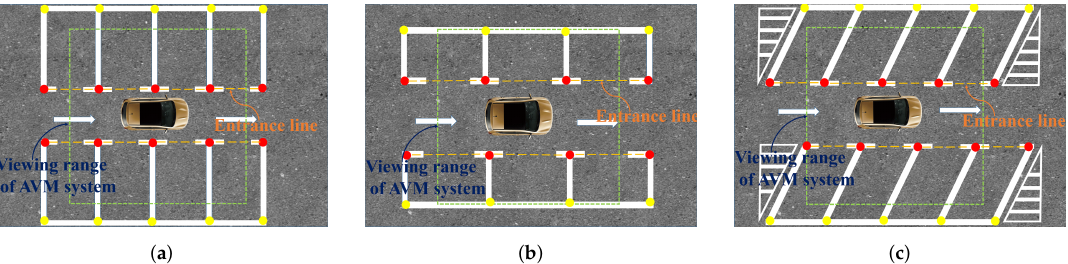
Figure 1. Three typical kinds of parking slots. ( a ) perpendicular parking slots; ( b ) parallel parking slots; ( c ) slanted parking slots. A parking slot consists of four vertices, of which the paired marking points of the entrance line are marked with red dots, and the other two invisible vertices are marked with yellow dots. The entrance lines and the viewing range of an AVM system are also marked out.